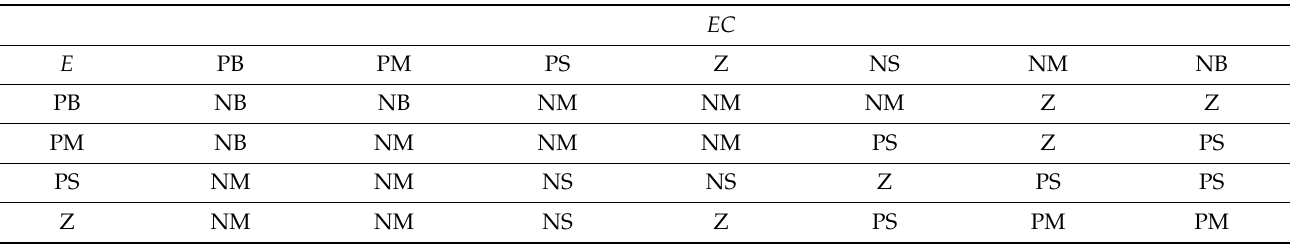
Table 3. Adjustment table of Kp control rule.